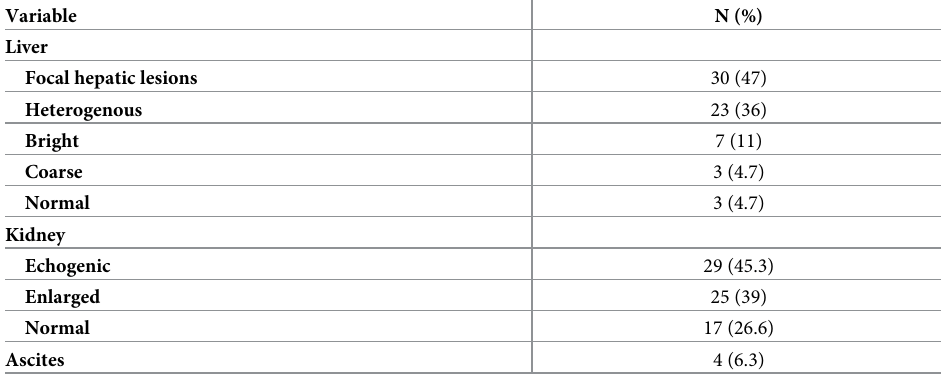
Table 5. Abdominal ultrasound findings in 64 cases of hepatorenal